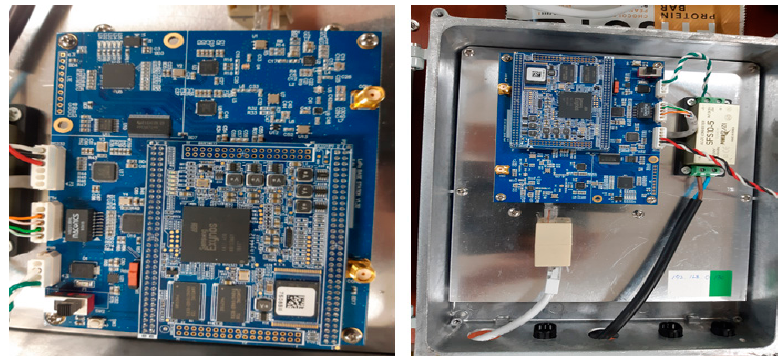
Figure 11. The board of multi ‐ channel gateway.